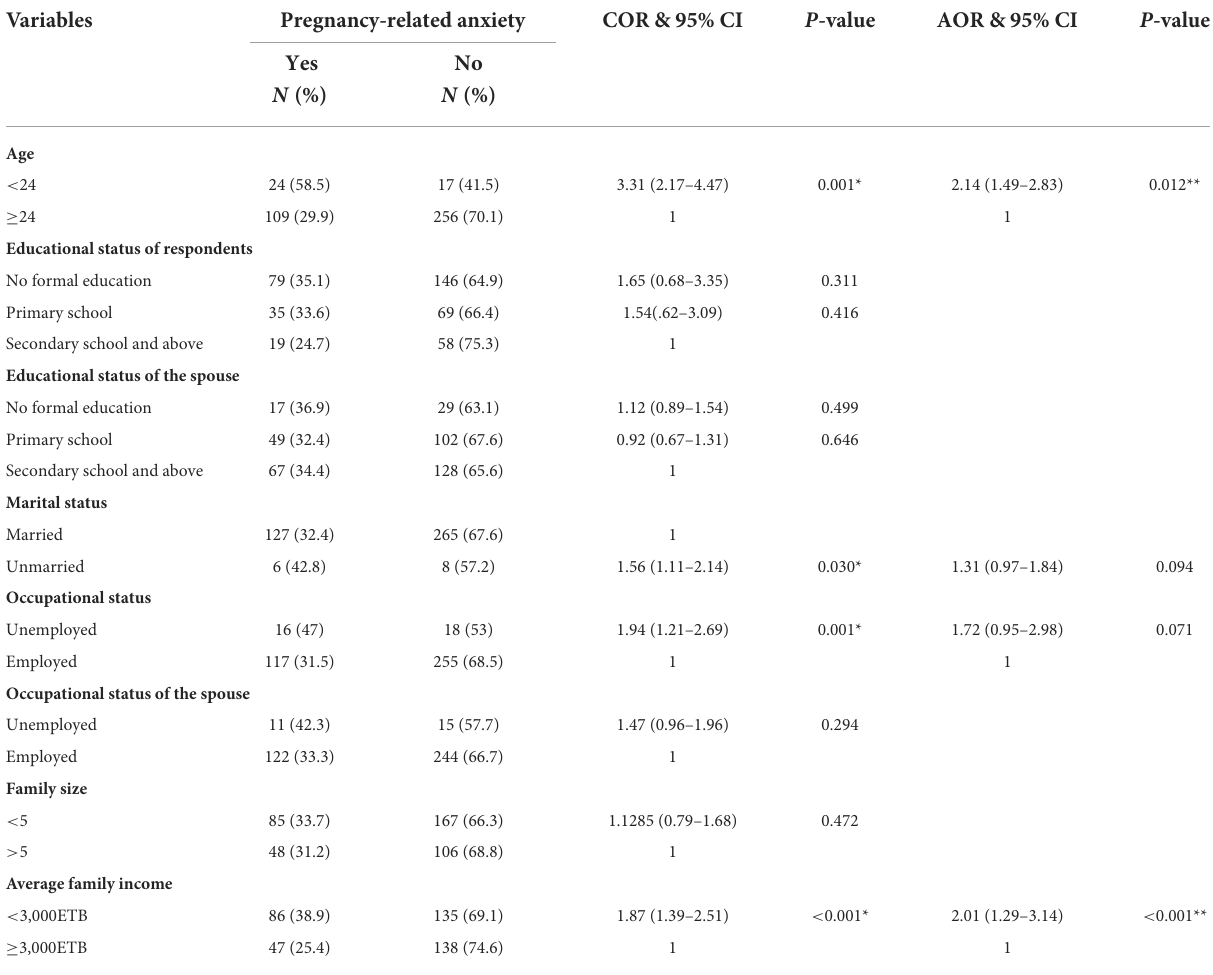
TABLE 4 Bivariate and Multivariate binary logistic regression analysis showing the association between pregnancy-related anxiety and socio-demographic variables among pregnant women attending ANC follow up Bedelle general hospital and Metu Karl comprehensive specialized hospital, 2021 ( N =